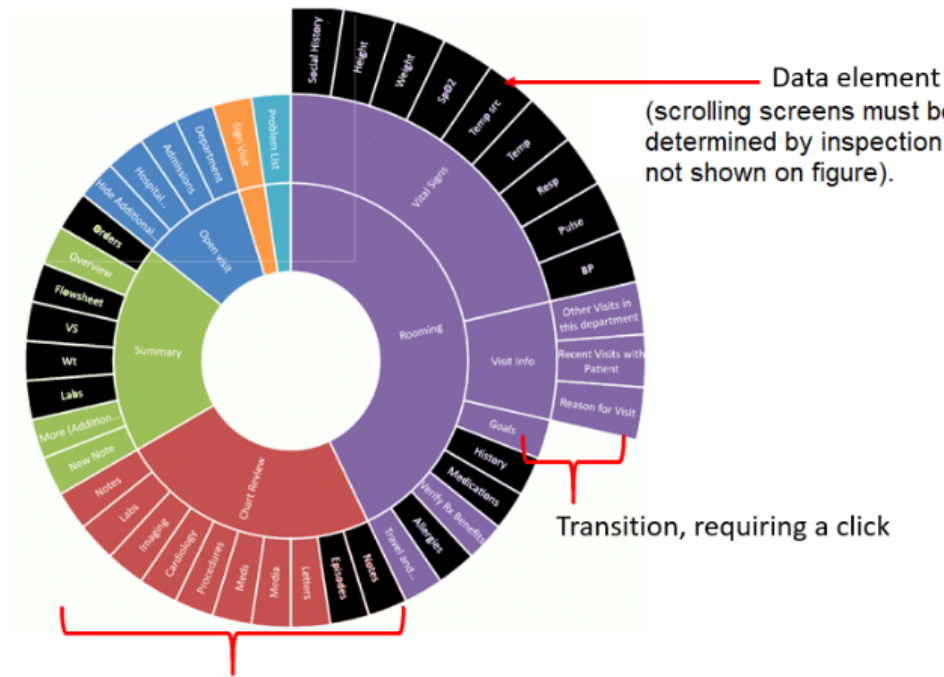
Figure 3. Display Fragmentation Index element calculations. DFI: Display Fragmentation Index.